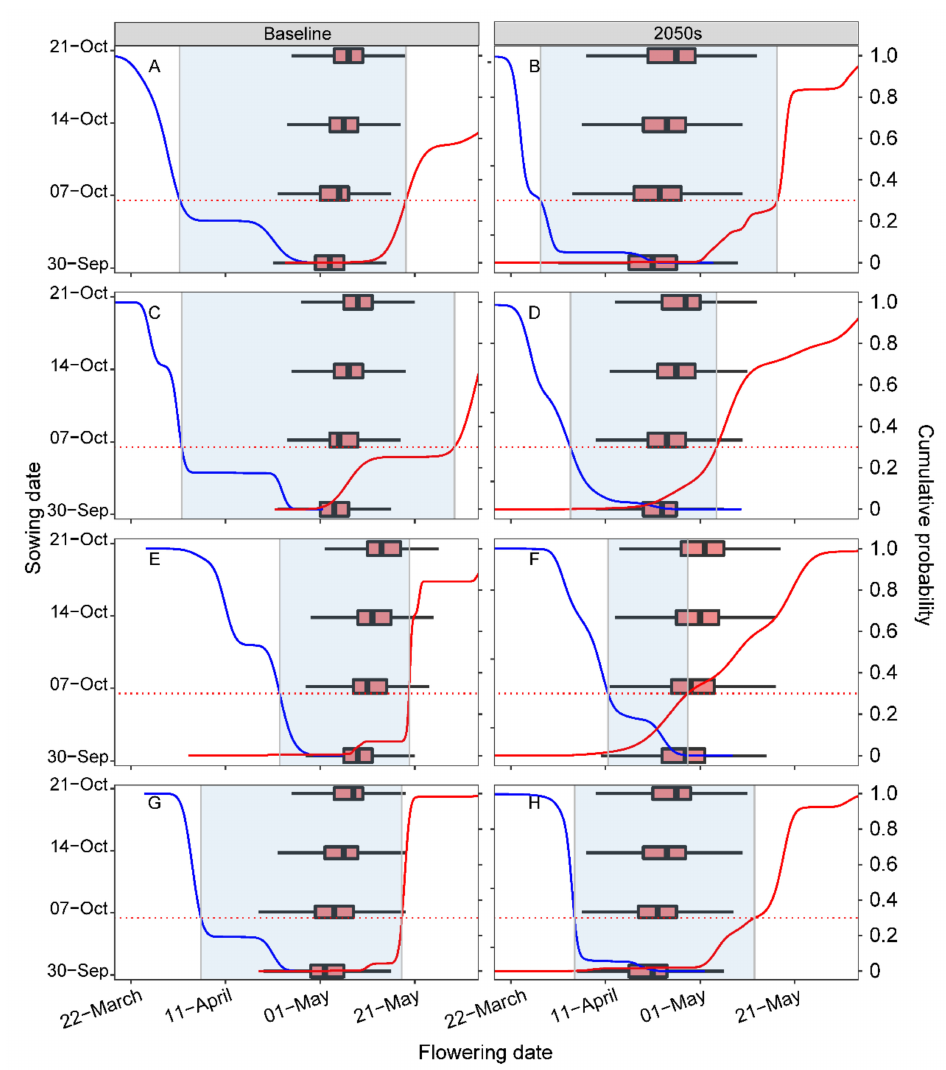
Figure 4. Impact of sowing date on the timing of flowering compared to the occurrence of extreme- temperature events under the periods of 1981–2010 (baseline) and 2031–2060 (2050s) across sites (( A , B ) Feixian; ( C , D ) Shenxian; ( E , F ) Weifang; ( G , H ) Yanzhou). The boxplot shows the variation in flowering date ( x -axis) for different sowing dates (left y -axis) over 30 years. Probabilities of last frost days (left blue solid line), and first heat days (right red solid line) are calculated as the percentiles of last frost and first heat days for baseline and 2050s. The low-risk period for frost and heat and preferred flowering window is highlighted in grey. The upper horizontal dashed red line indicates the 30% risk of first heat and frost